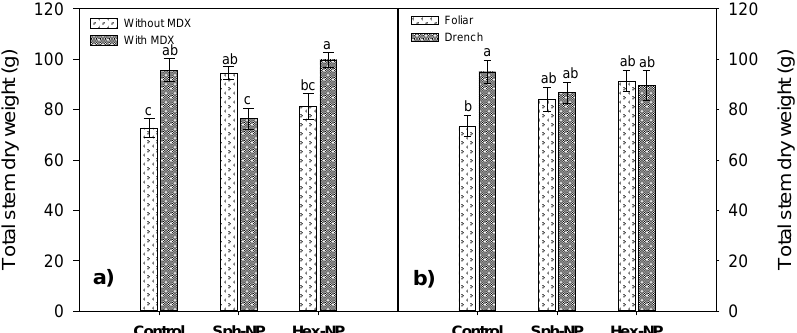
Figure 10. Effect of ZnO-NPs application on stem dry weight. ( a ) Morphology and maltodextin (MDX) interaction, ( b ) morphology and application method interaction. Bars represent the standard error of the mean. Different letters indicate significant differences according to Tukey´s multiple comparison test ( p < 0.05).